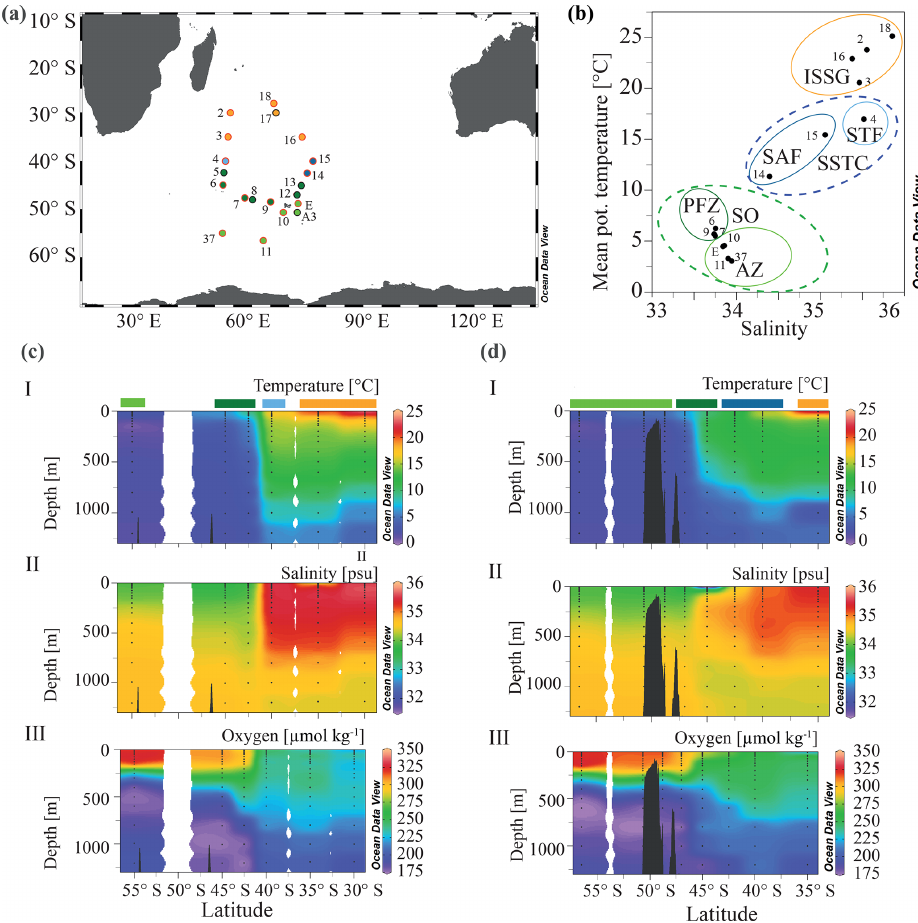
Figure 1. (a) The MD206 transect and OISO stations. Stations are colored according to water masses and encircled by sampling extent: black circles indicate stations where only CTD (conductivity, temperature, depth) data are provided, and stations encircled in red denote where additional samples for C, N, and community composition were taken. (b) A plot of potential temperature (in degrees Celsius ( ◦ C) and salinity (in practical salinity units)) using sea surface (7m) data of the stations used in further microbial and C / N analyses. The yellow circle highlights the Indian South Subtropical Gyre (ISSG), light blue circle the Subtropical Front (STF), blue circle the Subantarctic Front (SAF), dark green circle the Polar Front Zone (PFZ) and the light green circle indicates the Antarctic Zone (AZ); dashed lines indicate water masses clustered within ocean provinces: the blue line marks the South Subtropical Convergence province (SSTC), and the green line marks the Southern Ocean (SO); panels (c) and (d) show depth profiles of temperature, oxygen, and salinity along two transects of the OISO stations. Colored bars indicate water masses according to (b) . Panel (c) shows the western transect covering OISO stations 2, 3, 4, 5, 6, and 37 around 53 ± 1 ◦ E longitude; panel (d) shows the eastern transect of OISO stations 10, 11, 12, 13, 14, 15, 16, and E around 68 ± 5 ◦